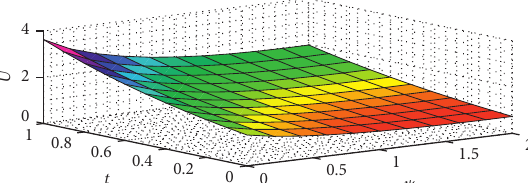
Figure 3: The surface graph of the approximated solution ( ψ ,t, ρ ) for α � 0 . 7. U 3